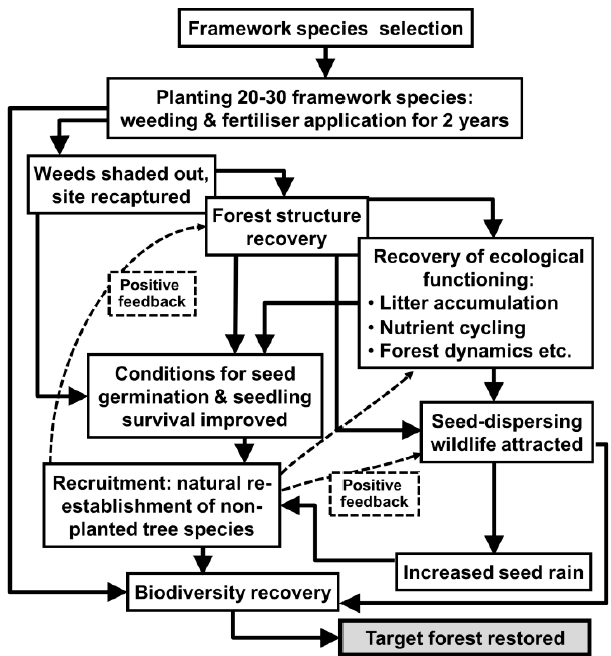
Figure 1. How the framework-species method works.